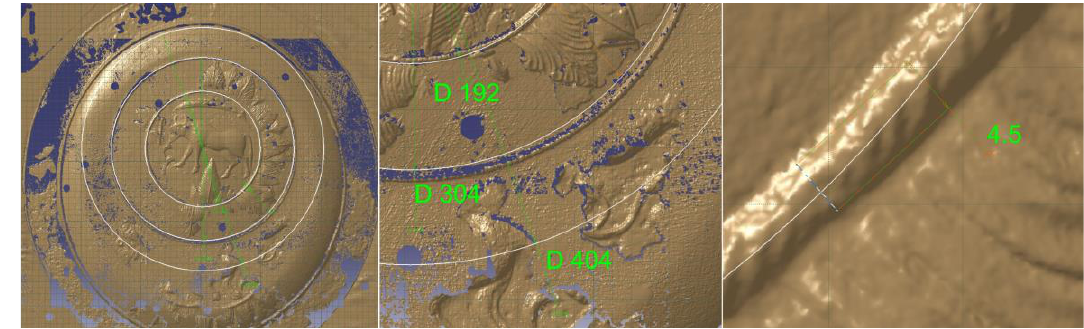
Figure 14. Dimensions of the three registers, as well as the width of the outer border.